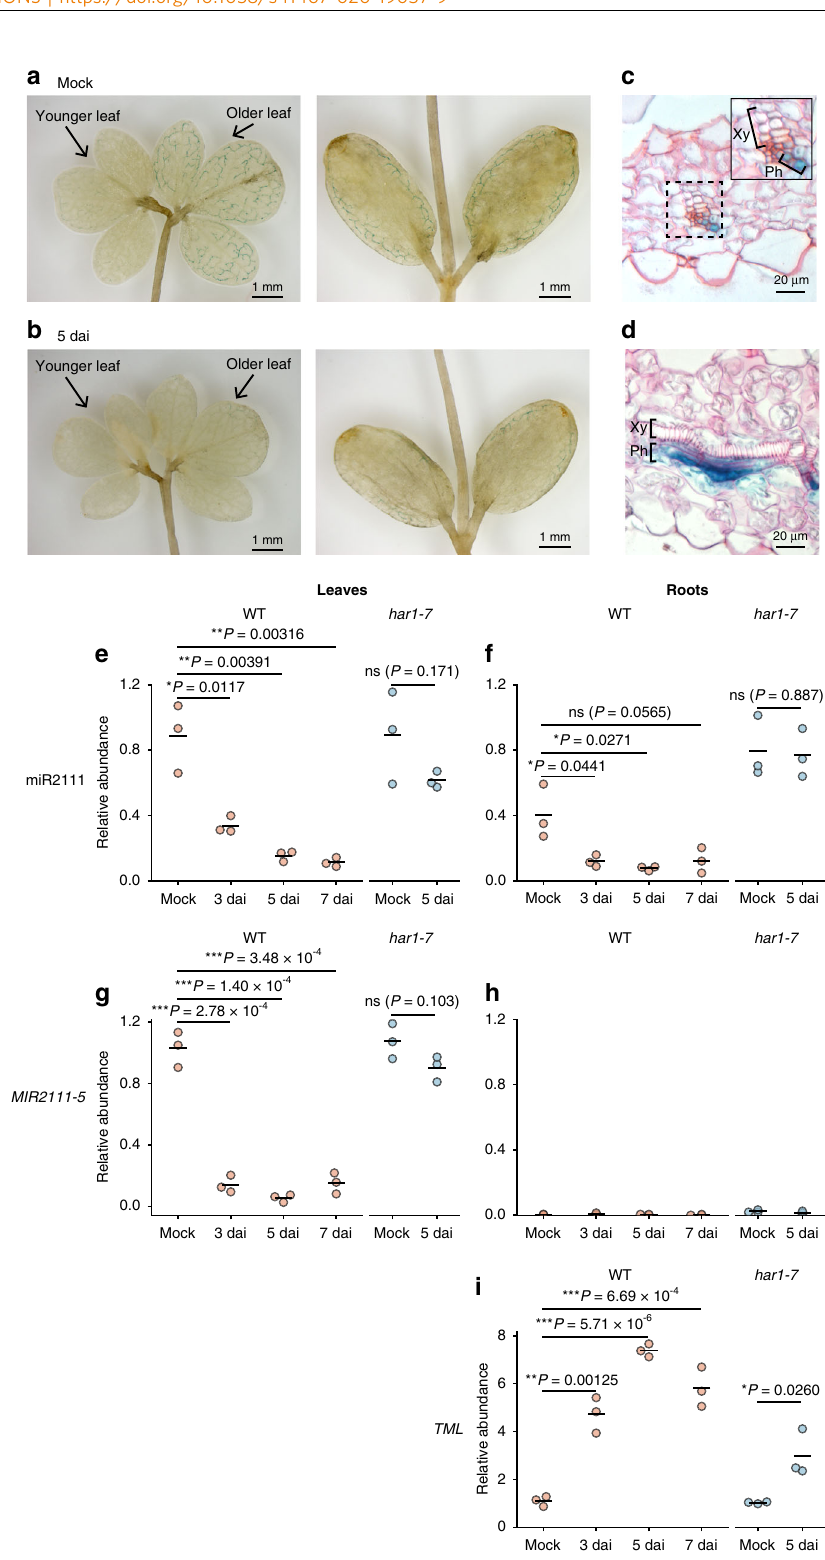
Fig. 3 MIR2111-5 was expressed mainly in the phloem of mature leaves. a – d GUS expression controlled by a 3.0-kb DNA fragment upstream of MIR2111-5 in true leaves (left) and cotyledon (right) of plants mock-treated ( a , c , d ) and inoculated with M. loti (5 days after inoculation) ( b ) were incubated in GUS staining buffer for 3 h. c , d Leaf sections counterstained with 0.1% safranin for 10 min. Xy xylem, Ph phloem. e – h qRT-PCR analyses of mature miR2111s ( e , f ) and MIR2111-5 ( f , g ), and TML ( i ) in leaves ( e , g ) and roots ( f , h , i ) at indicated days after inoculation (dai) with M. loti . Scatterplots show individual biological replicates as dots. Bars indicate mean values. All values were normalized by the mean value of wild-type mock-treated leaves. Two-sided Student ’ s t test was used to determine statistical difference compared with mock control: * P < 0.05; ** P < 0.01; *** P < 0.001; n.s. not signi fi